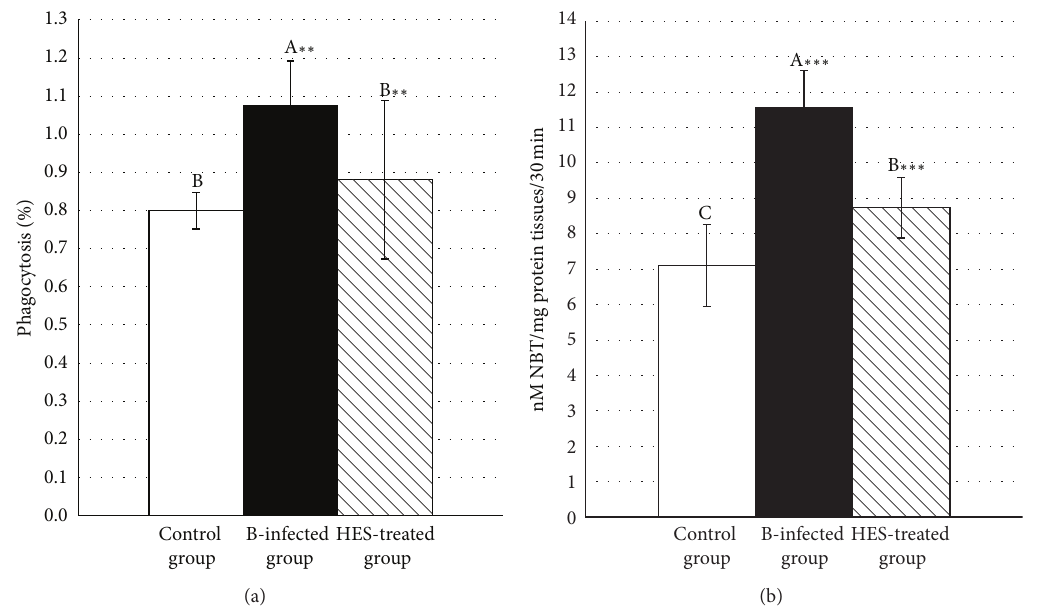
Figure 2: In vivo effect of hesperidin inoculation on phagocytic activities in blood (NBT index) (a) and intestinal reactive oxygen species (ROS) production (b). Mice were infected, each with 2 × 10 8 CFU of Aeromonas hydrophila per week for four consecutive weeks (B-infected group), and treated simultaneously with hesperidin at a dose of 250 mg/kg/week for four consecutive weeks (HES-treated group). At the end of week 4 following exposure and treatment, mice were sacrificed and weighted, the liver, spleen, and intestine were weighted, phagocytic activity was estimated in fresh blood, and intestinal ROS production was evaluated in intestinal homogenate. Values not sharing common superscripts denote significant differences.